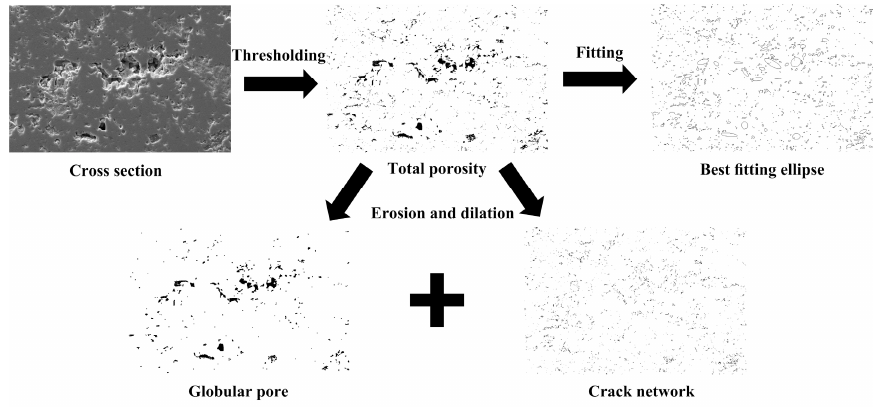
Figure 2. Implementation of thresholding and opening operation for microstructural features extraction. Table 2. Definitions of various microstructure features.